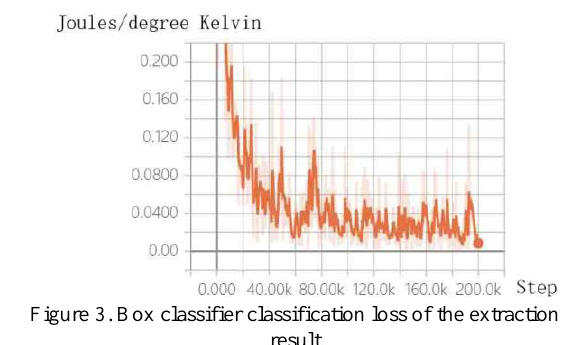
Figure 3. Box classifier classification loss of the extraction result